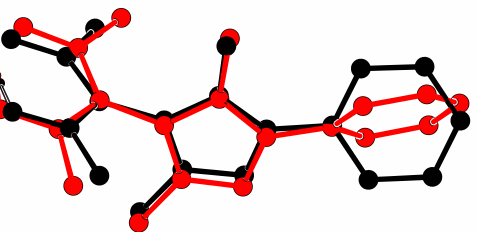
Figure 5. Overlay plot [30] of both molecules in the asymmetric residue in 1 (black: molecule 1 as shown in Figure 3, red: molecule 2 under symmetry operator − x , − y , − z ; C bonded hydrogens